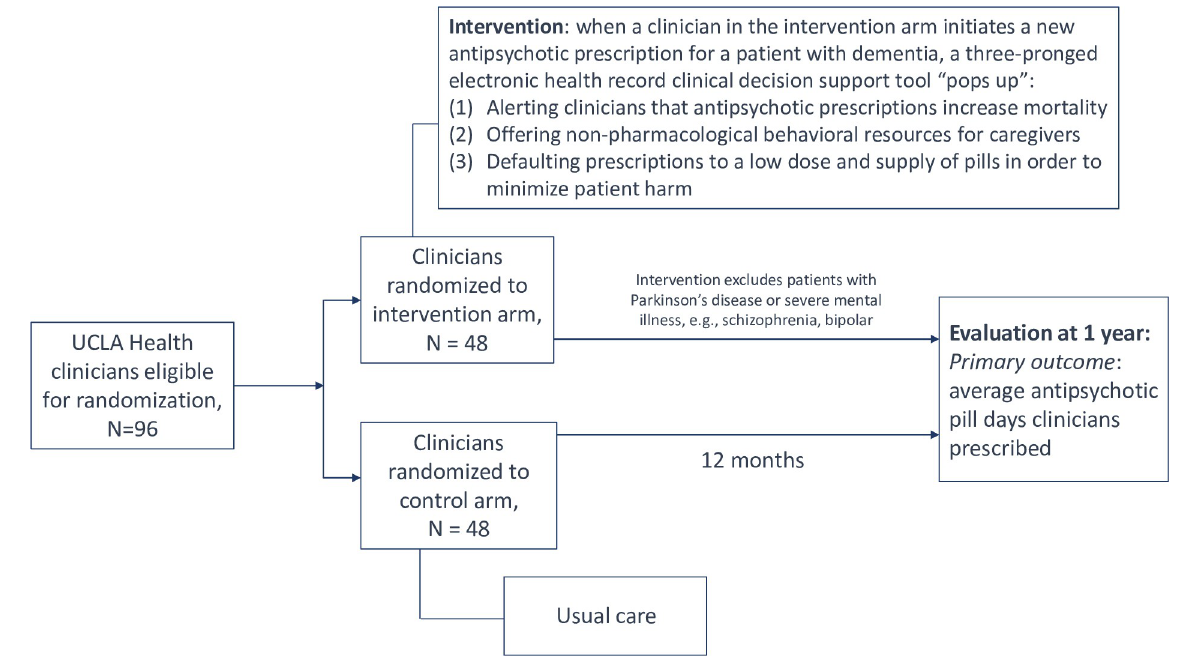
Fig 2. EHR CDS tool design. EHR = electronic health records; CDS = clinical decision